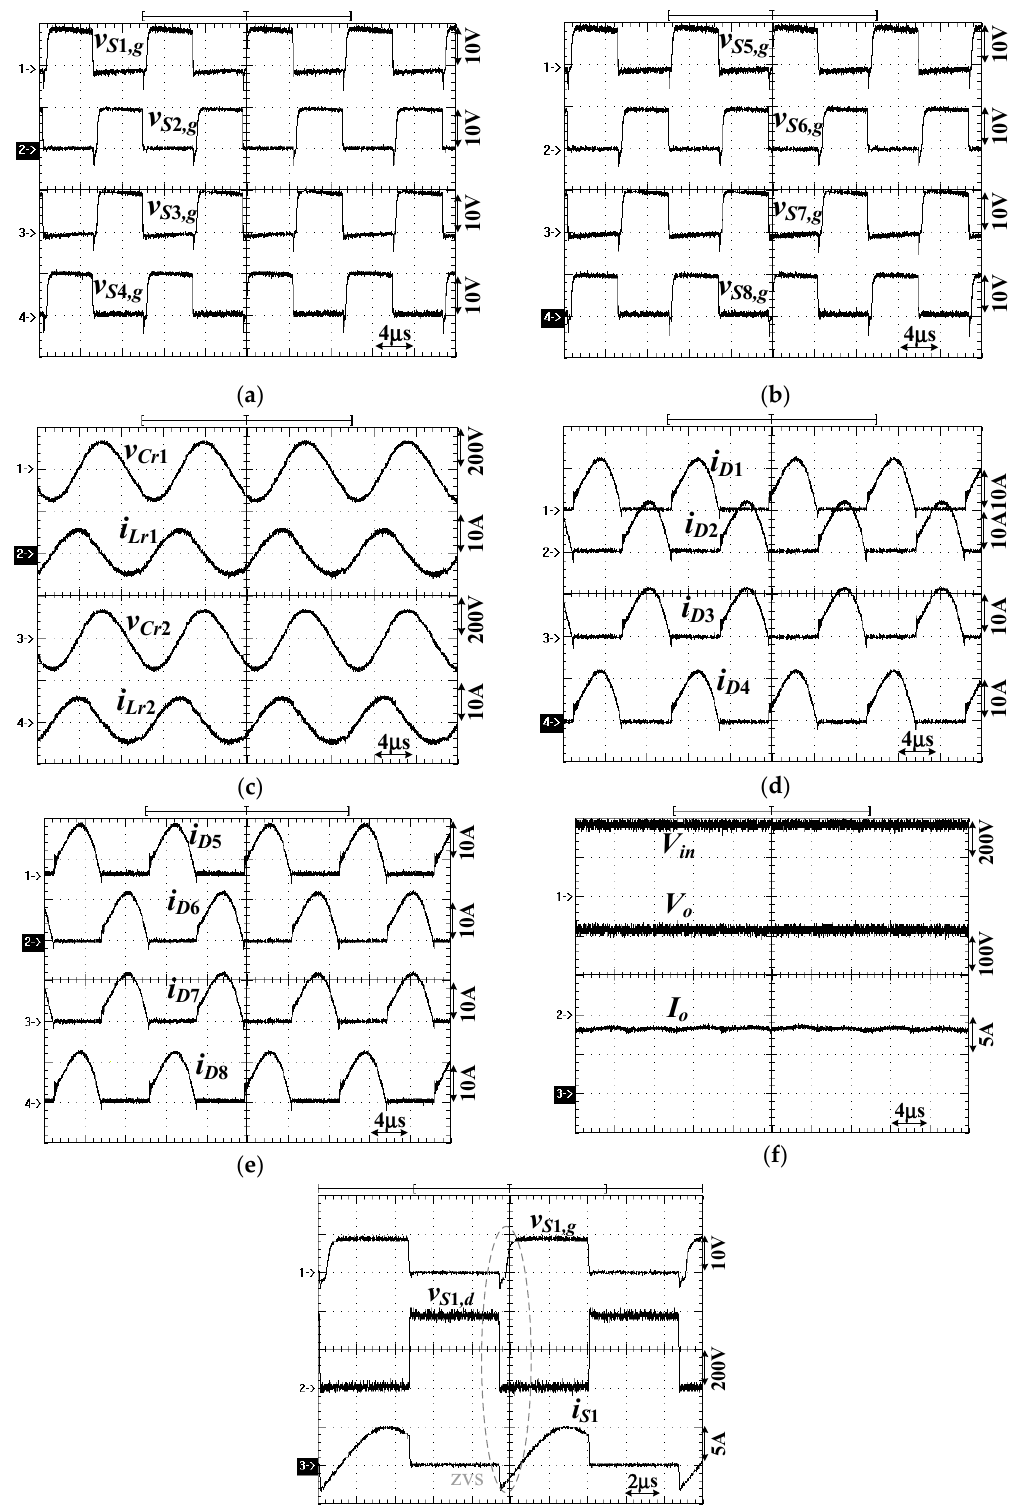
Figure 9. Measured results at 225 V output and 2 kW load under the high output voltage range. ( a ) PWM signals v S 1, g ~ v S 4, g ; ( b ) PWM signals v S 5, g ~ v S 8, g ; ( c ) v Cr 1 , i Lr 1 , v Cr 2 , i Lr 2 ; ( d ) diode currents i D 1 ~ i D 4 ; ( e ) diode currents i D 5 ~ i D 8 ; ( f ) V in , V o , I o ; and ( g ) v S 1 ,g , v S 1 ,d , i S 1 .